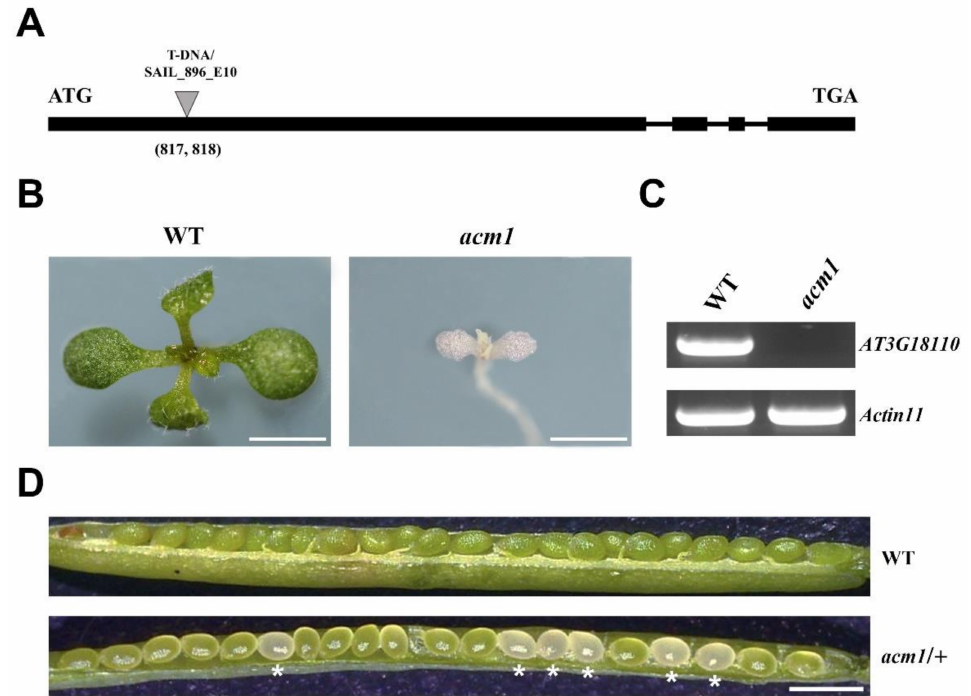
Figure 1. Phenotype of the acm1 mutant. ( A ) Schematic diagram of the ACM1 gene. Exons and introns are indicated by black boxes and lines respectively. The T-DNA insertion by the triangle; ATG represents the initiation codon and TGA represents the stop codon. ( B ) Albino phenotype of the acm1 mutant. Ten-day-old plants were grown on 1/2 MS medium with sucrose. Scale bar: 3 mm. ( C ) Reverse transcription PCR analysis. RT-PCR was performed using specific primers for AT3G18110 and Actin 11 for 29 cycles for WT and acm1 . ( D ) The ovules of heterozygous acm1 /+ mutant silique. The asterisks indicate albino ovules. Scale bar is 1